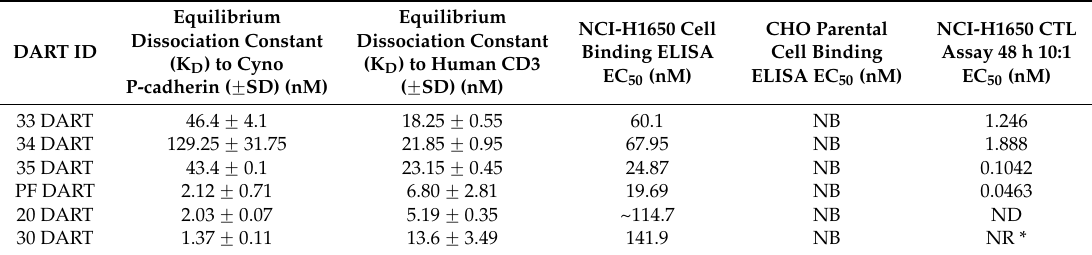
Summary table of DART equilibrium dissociation constants (K D ) to cynomolgus monkey P-cadherin and human CD3, ELISA cell binding EC 50 values to NCI-H1650 and control P-cadherin-negative cells, and CTL-directed of NCI-H1650 adenocarcinoma cells by anti-P-cadherin/ anti-CD3 DART proteins. * = samples were tested on a separate date with different donor effector cells. NB = no binding detected; ND = EC 50 not determined; NR = no